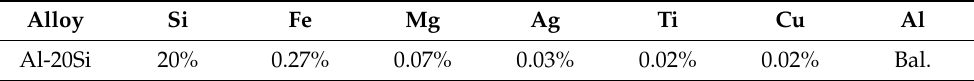
Table 1. Mass fractions of alloying elements in the gas-atomized Al-20Si powder particles. Alloy Si Fe